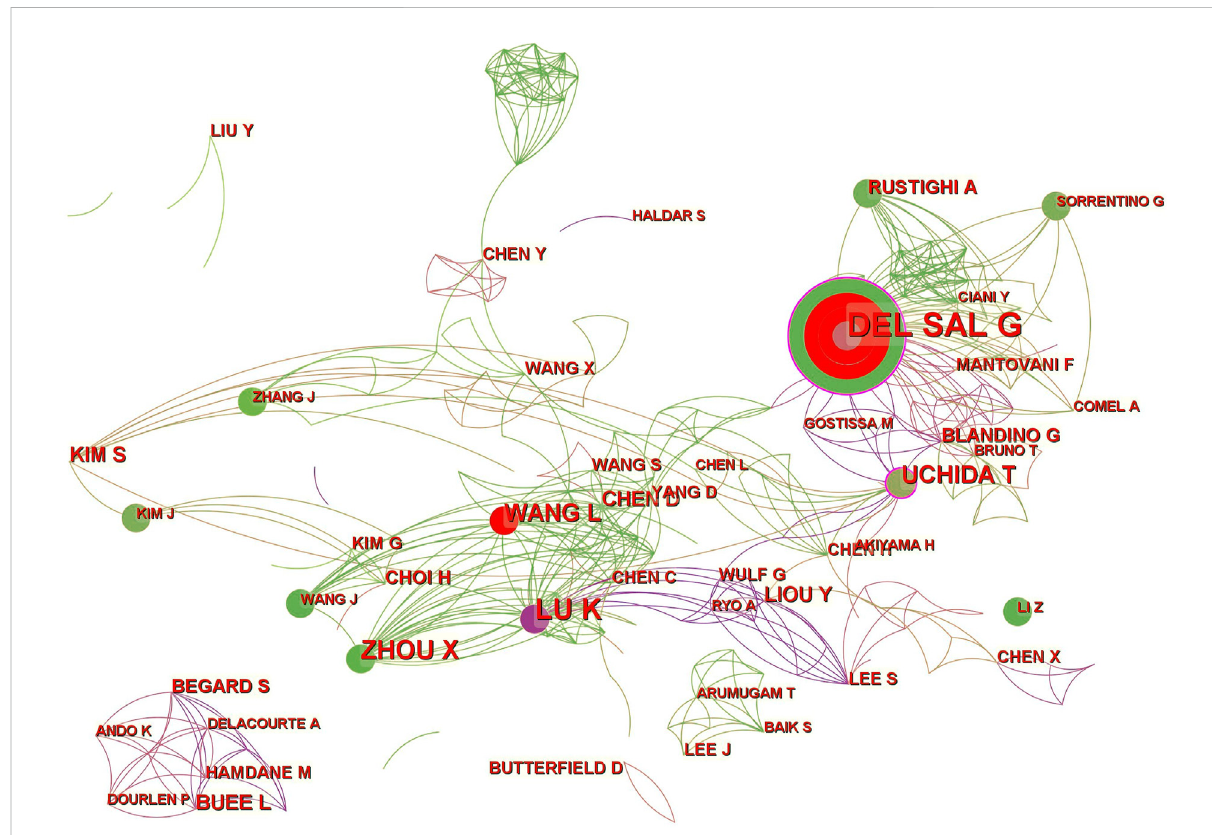
FIGURE 7 CiteSpace visualization map of authors involved. A circle represents an author, and the size of the circle represents the author ’ s number of articles. The purple part of the circle indicates the author ’ s centrality in the fi eld.